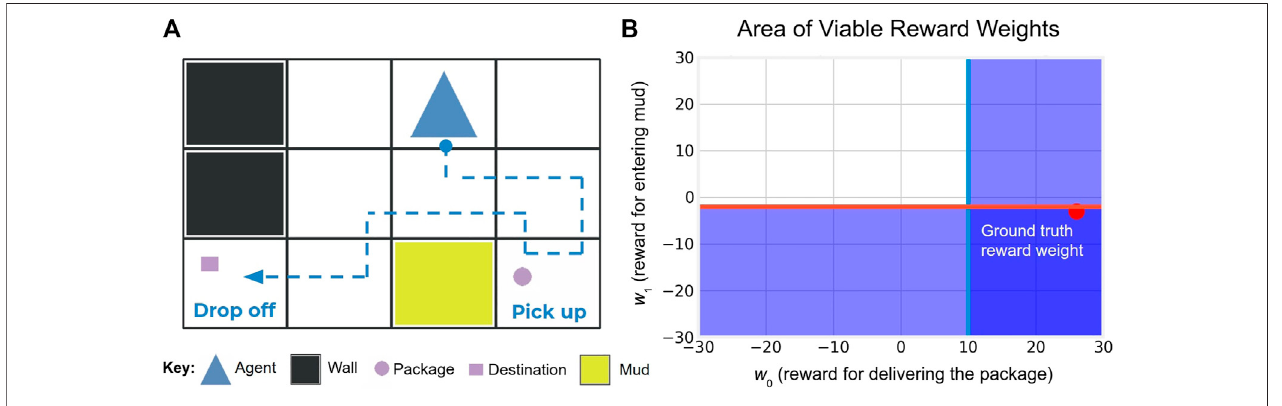
FIGURE 1 | (A) Ademonstration D ofanoptimalpolicy π inthedelivery domain.Agentaimstodeliverthepackagetothedestinationwhileavoidingwallsandavoiding mud ifthe detourisnottoo costly. (B) The leftdemonstration can be translatedintoa set ofhalf-space constraints onthe underlying policyrewardweights using Eq. 4 . The darker shaded region is where all constraints (the red and light blue lines) hold true, which corresponds to the behavior equivalence class BEC( D | π ), see Section